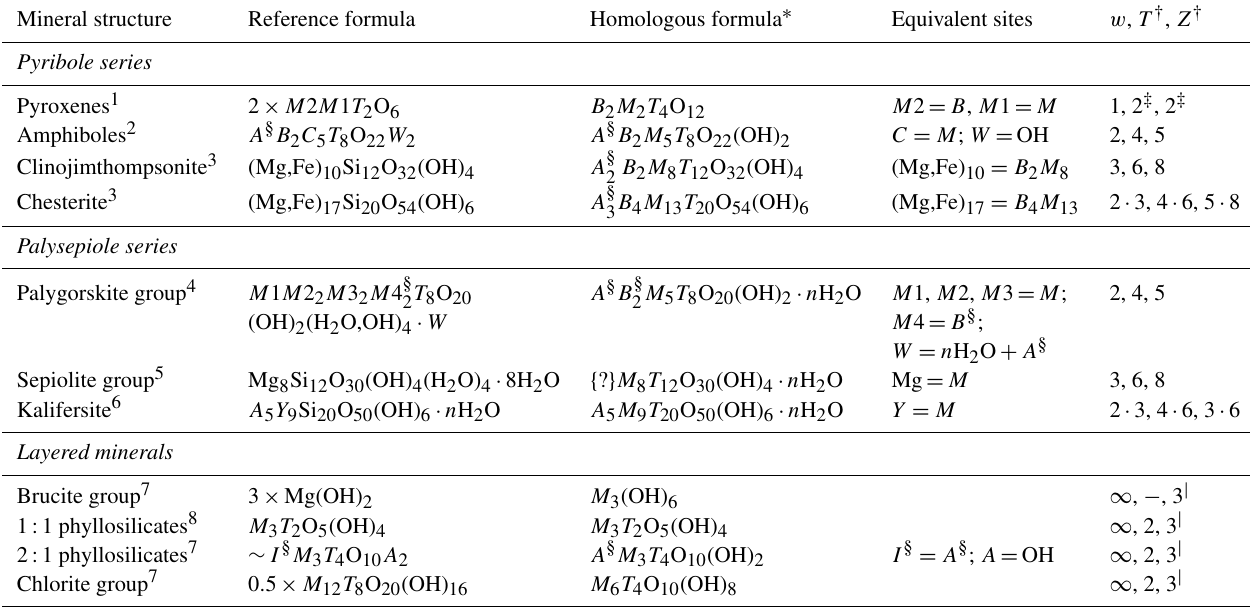
Table 1. Relationships between modular rock-forming minerals, chemical formulae, and module widths. Mineral structure Reference formula Homologous formula